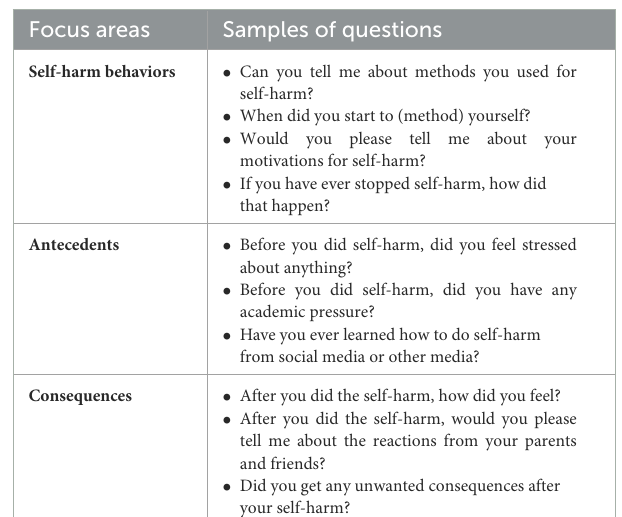
TABLE 1 Focus areas of semi-structured